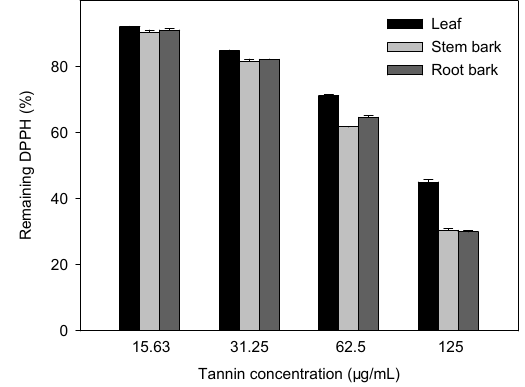
Figure 3. Remaining DPPH after addition of the condensed tannins from different parts of A. confusa for 30